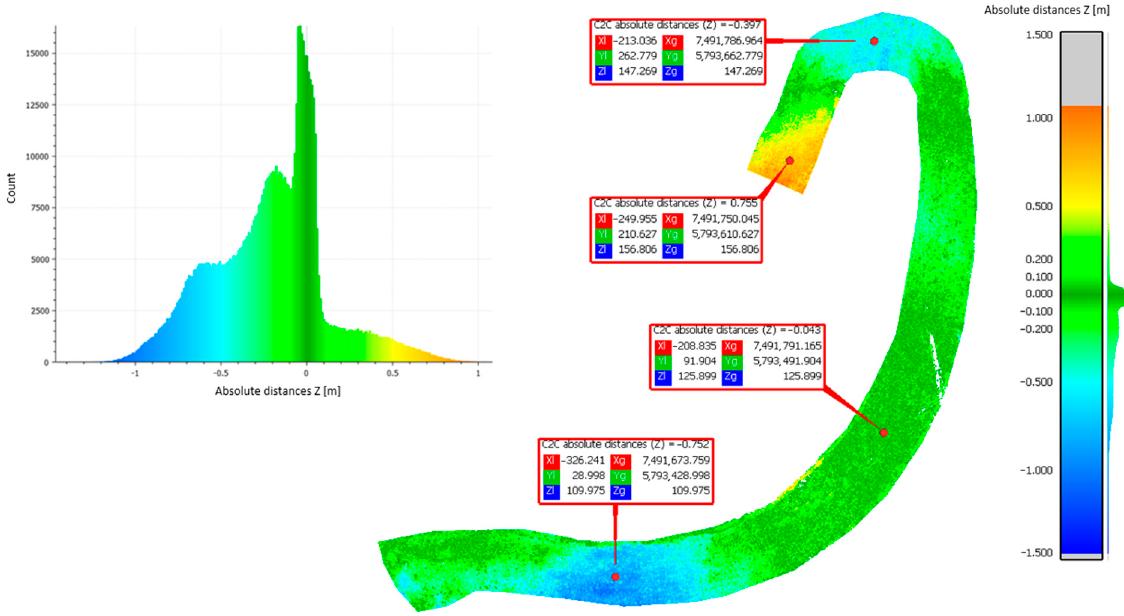
Figure 8. C2C distance analyses for set 3 compared to set 1.